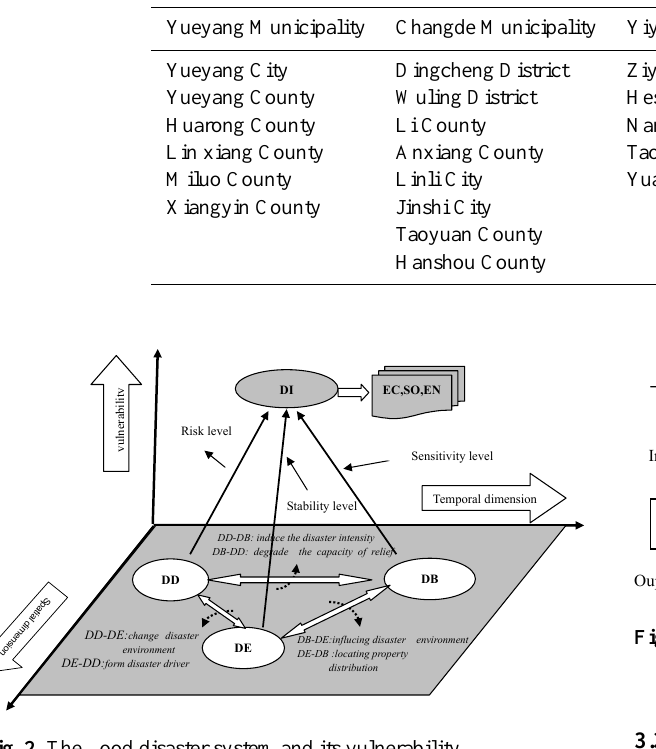
Fig.3 Flood disaster vulnerability and its decomposition